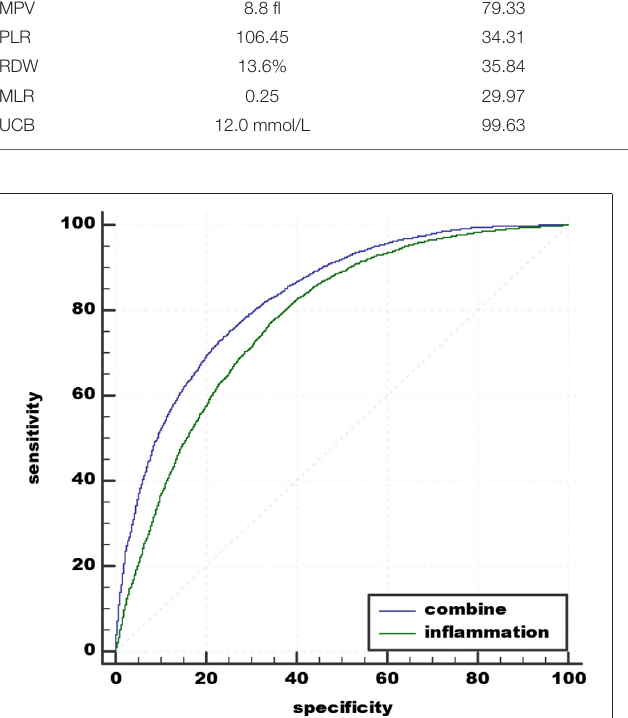
FIGURE 3 | Admission of the combination of MLR, MPV, PLR, RDW, and the combination of MLR, MPV, PLR, RDW, and UCB in predicting acute schizophrenia. UCB, unconjugated bilirubin; MPV, mean platelet volume; RDW, red cell distribution width; NLR, neutrophil/lymphocyte ratio; MLR, monocyte/lymphocyte ratio; PLR, platelet/lymphocyte ratio.